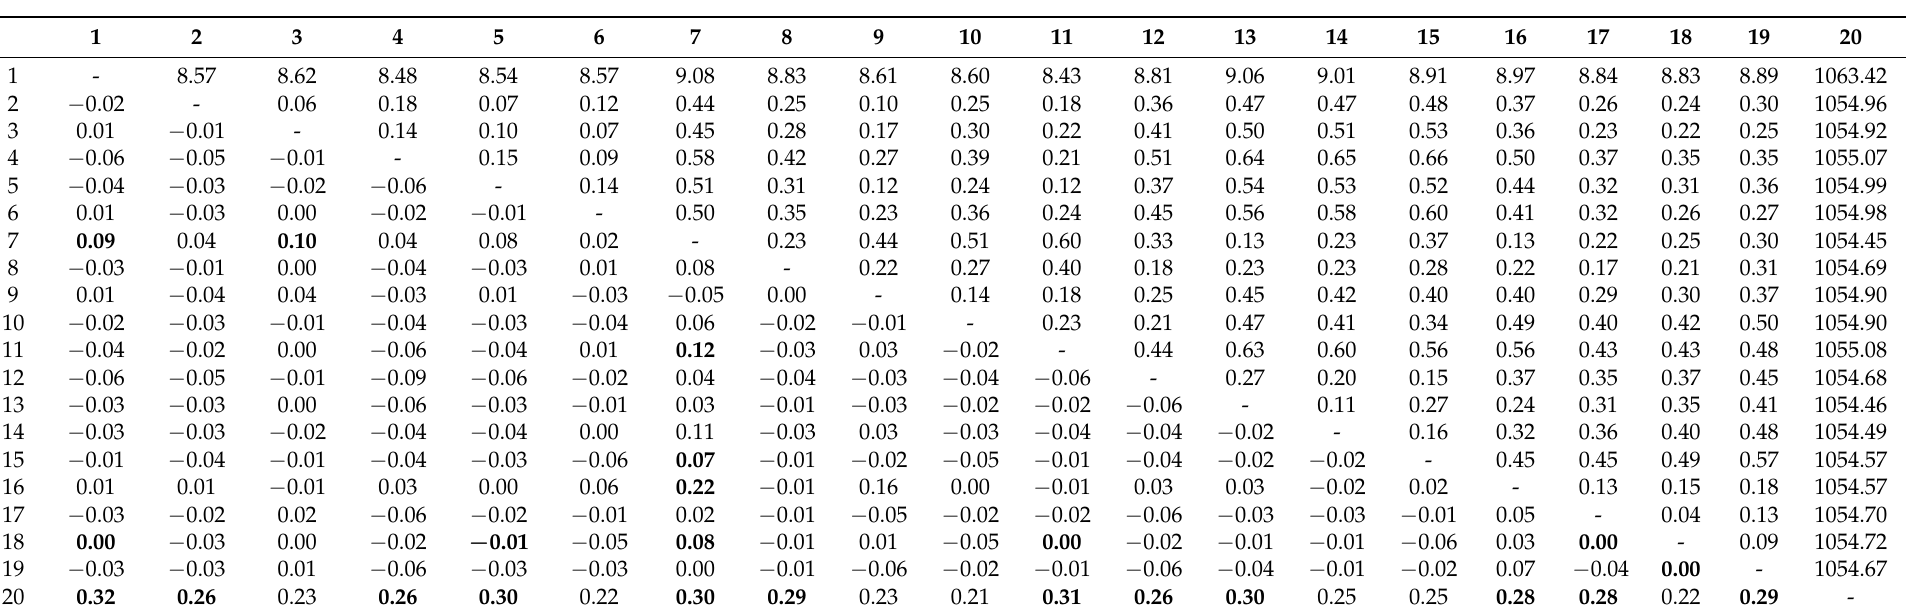
Table 5. Exact test for pairwise Φ ST comparisons performed (under diagonal), as well as geographic distances (km) among locations (above